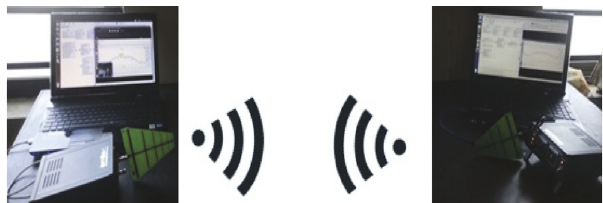
Figure 3: Project setup for transmitter and receiver of energy based spectrum